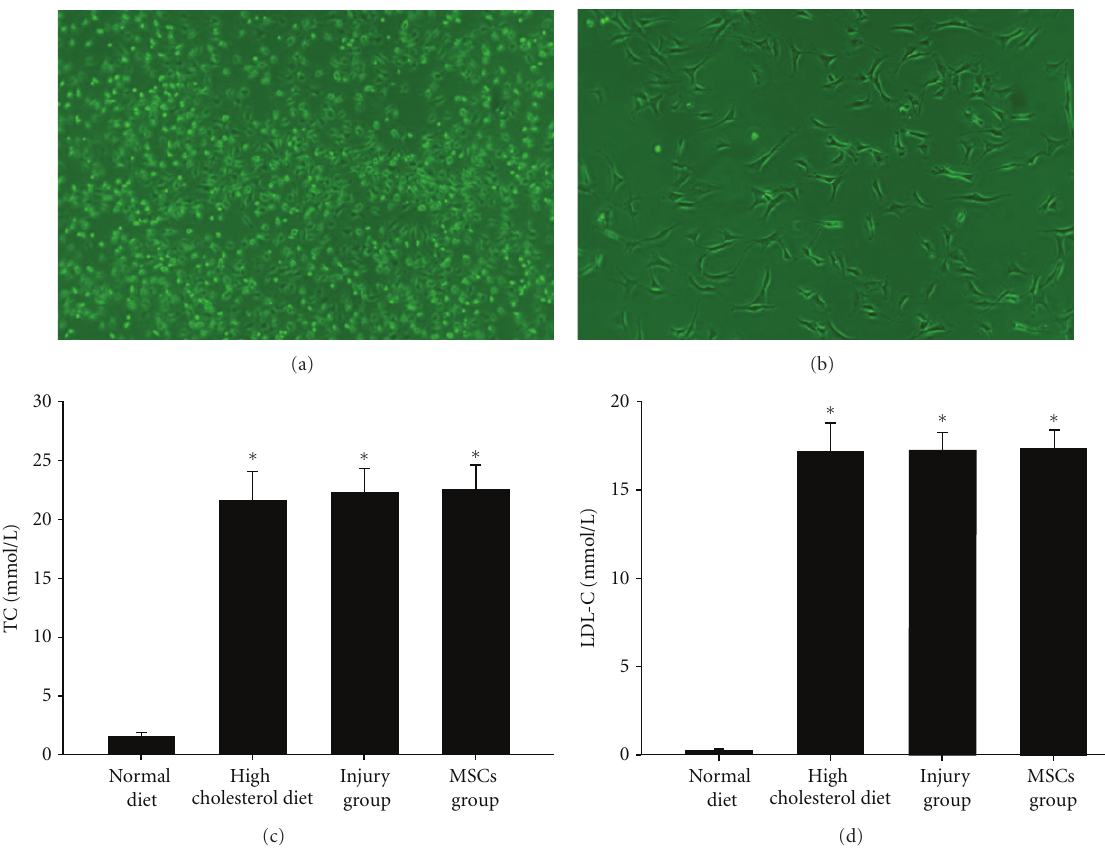
Figure 1: Identification of BM-MSCs and the profile of lipid level in cholesterol-rich fed rats. Phase contrast microscopy depicted that a few small, bright, round cells were present in the primary culture (a). Phase contrast microscopy revealed that BM-MSCs were characterized as a fibroblast-like spindle-shaped morphology (b). Baseline of serum lipid content before received cholesterol-rich diet did not significantly di ff er among three groups. Cholesterol-rich diet significantly increased total serum cholesterol (c), and LDL (d) levels after angioplasty in rats. The data were expressed as means ± SEM. n = 8 per group. ∗ P < 0 . 05 versus normal diet